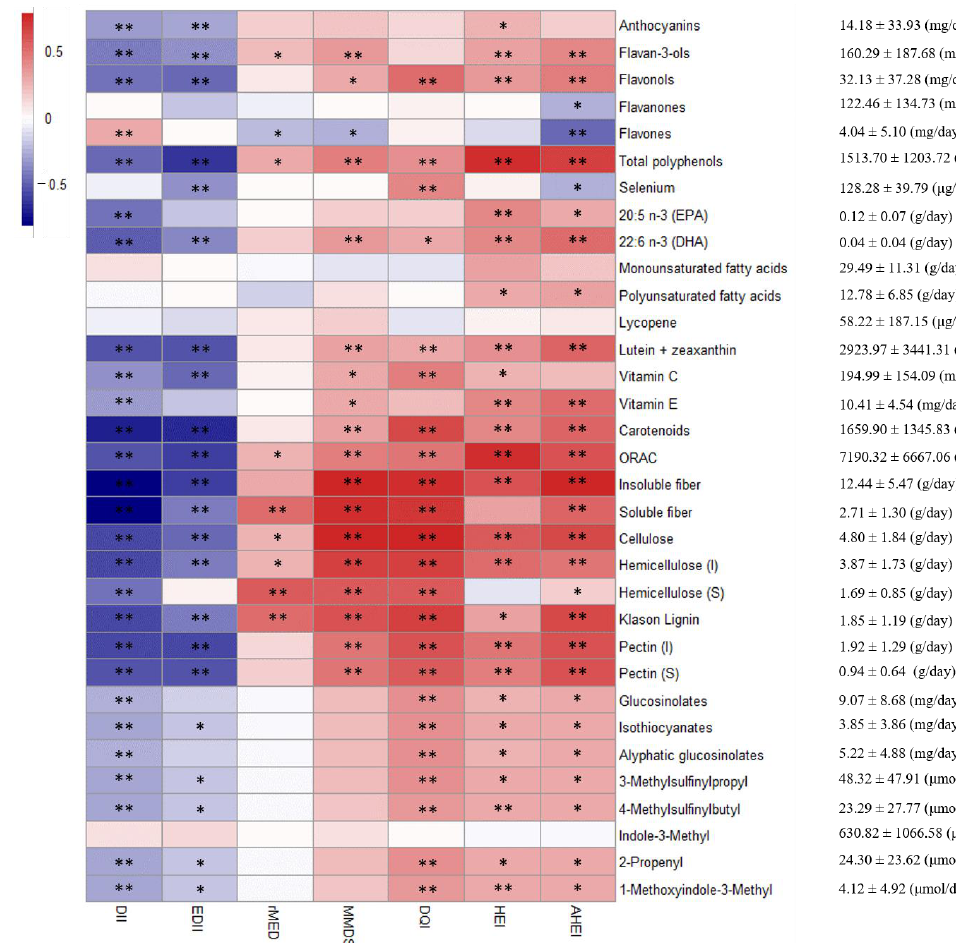
Figure 3. Heatmap showing β-coefficient values resulting from univariate linear regressions adjusting by age and energy among six different dietary indexes and health-related compounds. Rows include compounds with previously reported beneficial effect as (poly)phenols, fatty acids, carotenoids, vitamins, fiber, glucosinolates and isothiocyanates. Blue and red colors denote negative and positive association, respectively. Asterisks indicate the significance of the association degree * p ≤ 0.05; ** p ≤ 0.01.